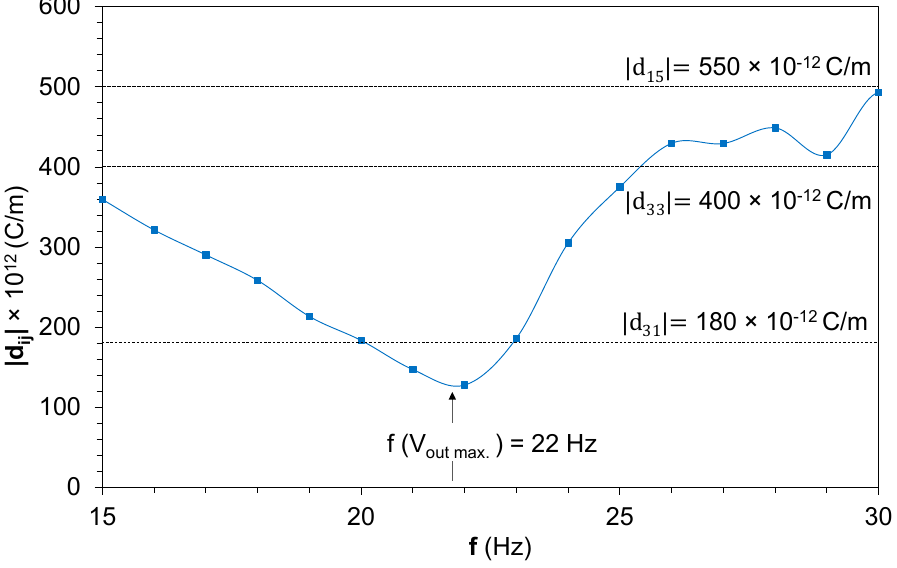
Figure 9. Theoretical d ij piezoelectric coefficient modulus versus the frequency of excitation.